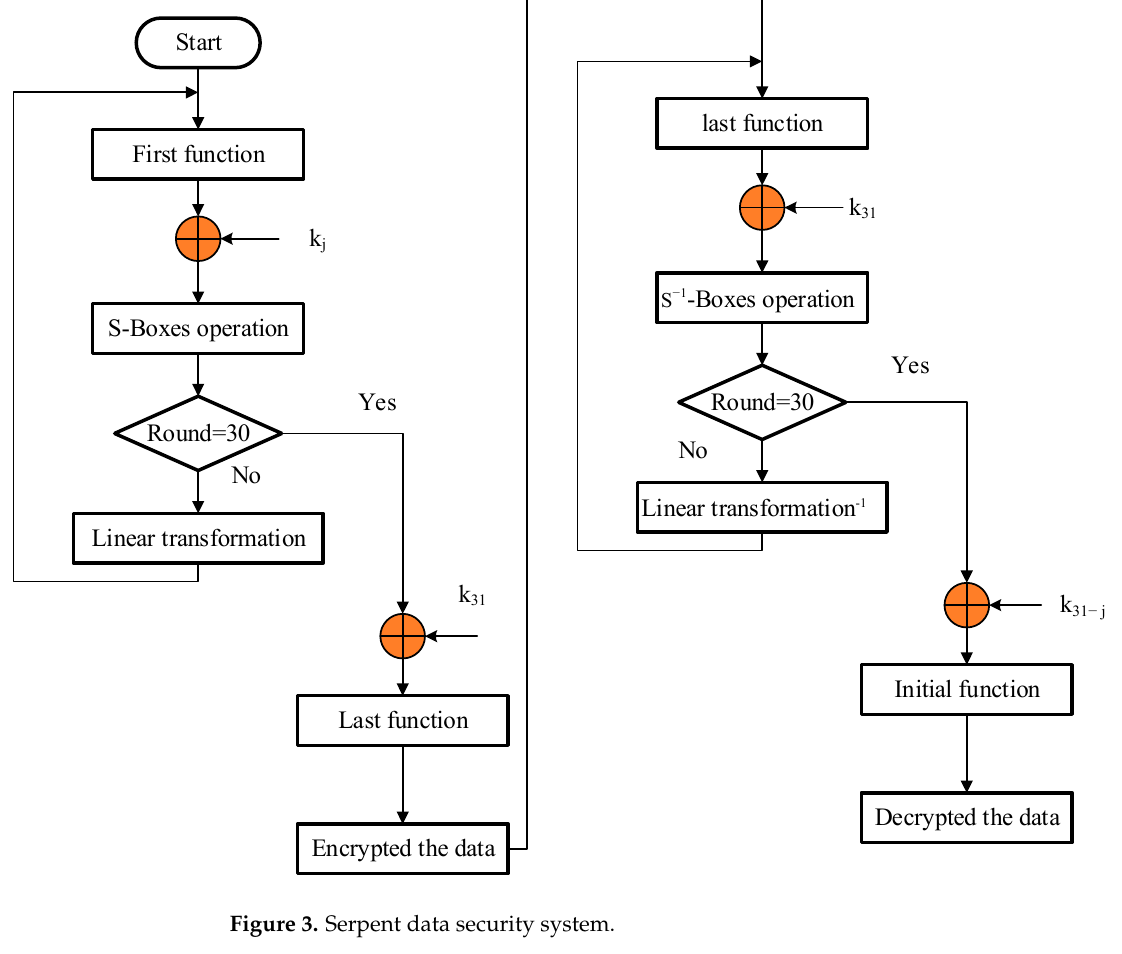
Figure 3. Serpent data security system.